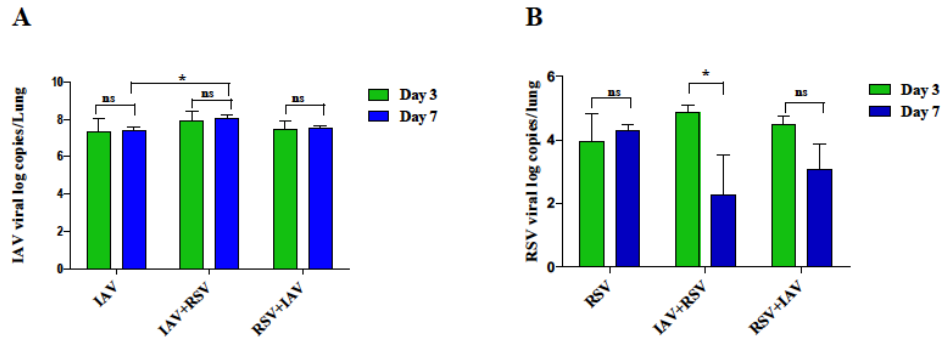
Figure 3. IAV and RSV lung viral loads in co-infection mouse model . On day 3 or 7 post-infection, mRNA was extracted from lungs and processed for real time PCR analysis of ( A ) IAV and ( B ) RSV genes. Results represent mean pooled values +/ − SEM from three independent experiments, ( n = 5 – 9 mice per group). Asterisks denote significant differences between experimental groups; * p < 0.05; ns = not significant. Comparison among groups was performed using the nonparametric test (2 independent variables: Mann – Whitney).